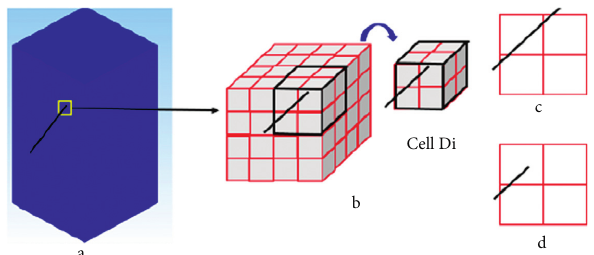
Figure 6: Representation of the discontinuous cellular automaton model and its different